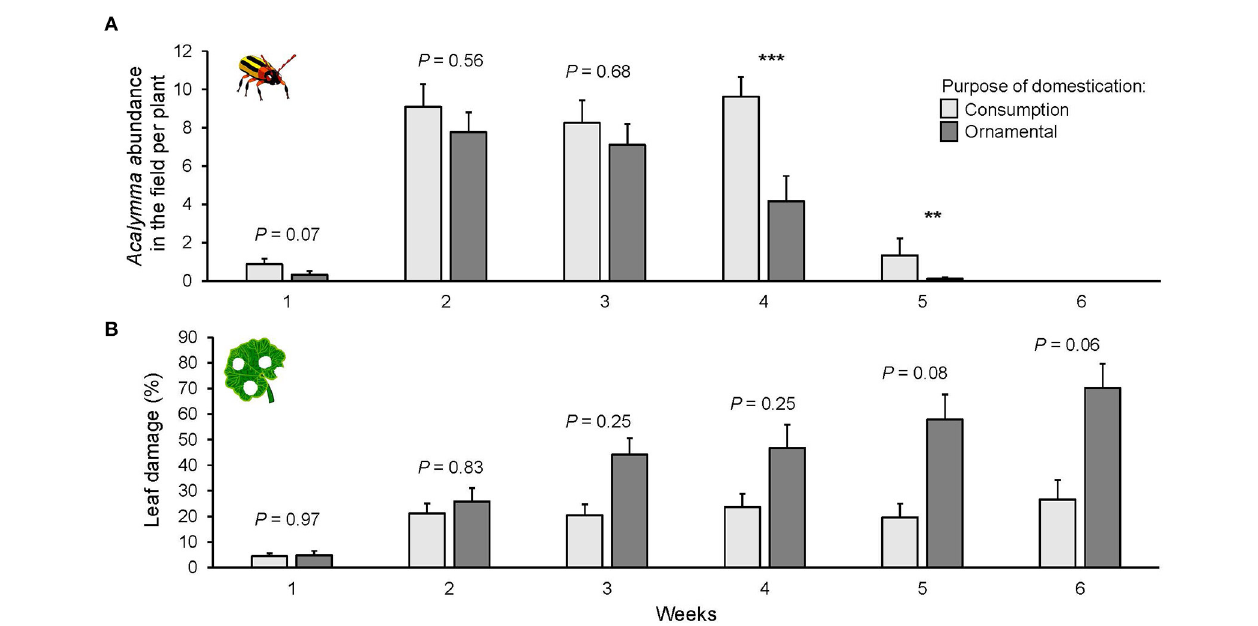
FIGURE 6 | Mean number of Acalymma spp. beetles per plant (A) and percent of leaf damage (B) on squash varieties domesticated for different purposes in a common garden field experiment in Puerto Escondido, Oaxaca, Mexico. Data were recorded once per week for 6 weeks. Bars represent means ( ± SE). Light-colored bars are varieties domesticated for consumption and dark-colored bars are varieties domesticated for an ornamental purpose. P -values are given for treatment [linear mixed model] per week and followed by pairwise comparisons of Least Squares Means (LS means). ** P < 0.01, *** P <